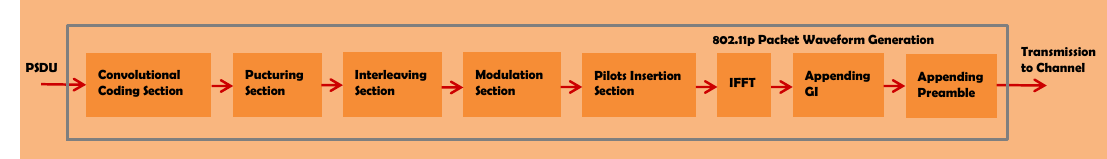
Figure 2. Transmitter block diagram of IEEE